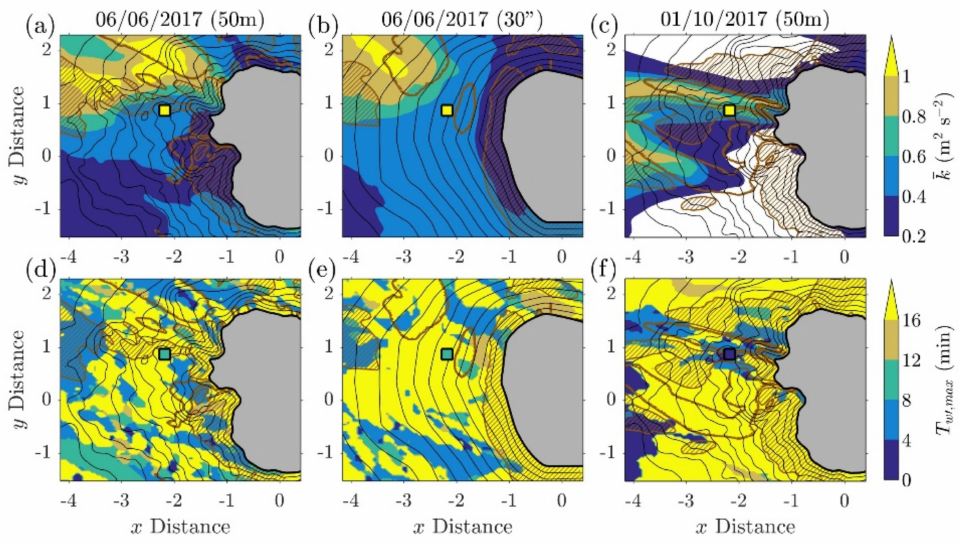
Figure 9. As Figure 8 but for: ( a – c ) average resolved turbulence kinetic energy, ( d – f ) period of maximum amplitude of the vertical velocity perturbation